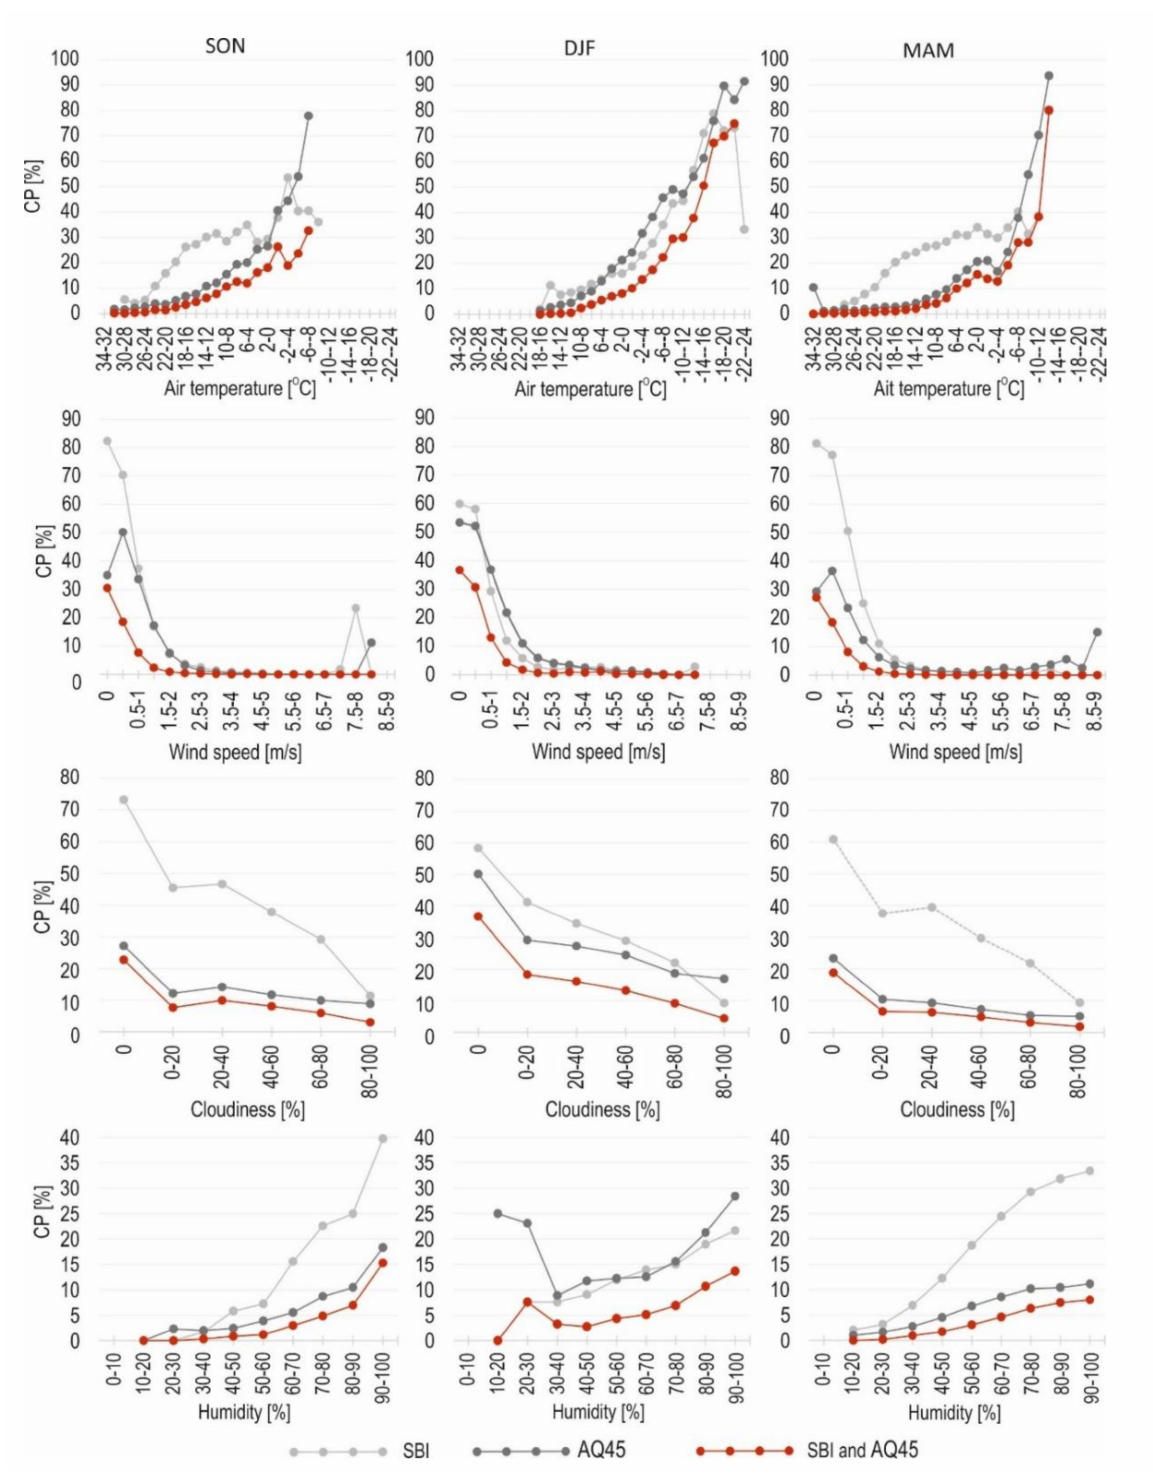
Figure 12. Average conditional probability (CP) of all air temperature inversions (SBI, γ > 0.5 K), polluted air (AQ45 = AQ4 + AQ5) and simultaneous occurrence of SBI and AQ45 for ranges of selected meteorological elements in autumn (SON) winter (DJF) and spring (MAM) based on hourly data; averages calculated from air monitoring